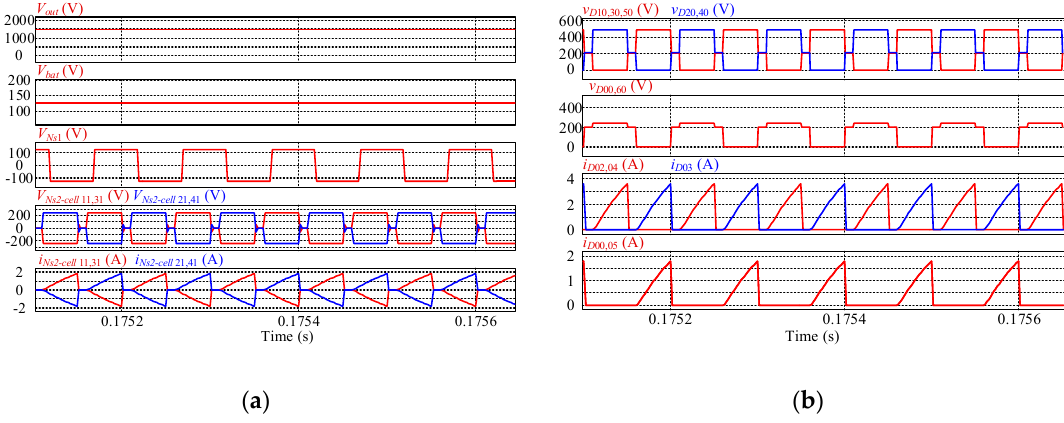
Figure 13. Steady-state waveforms with PV source: ( a ) voltage/current of basic cells; ( b ) voltage/current of diodes.